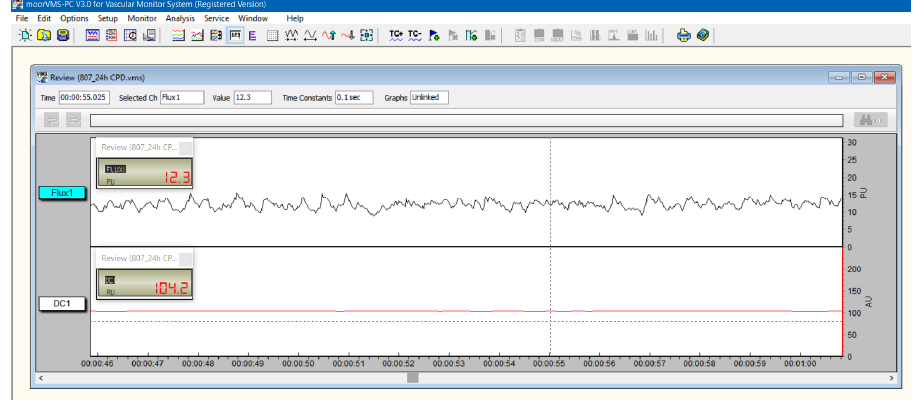
Figure 3. LDF pulp signal recorded in tooth 807, 24 h after DPC (T1).